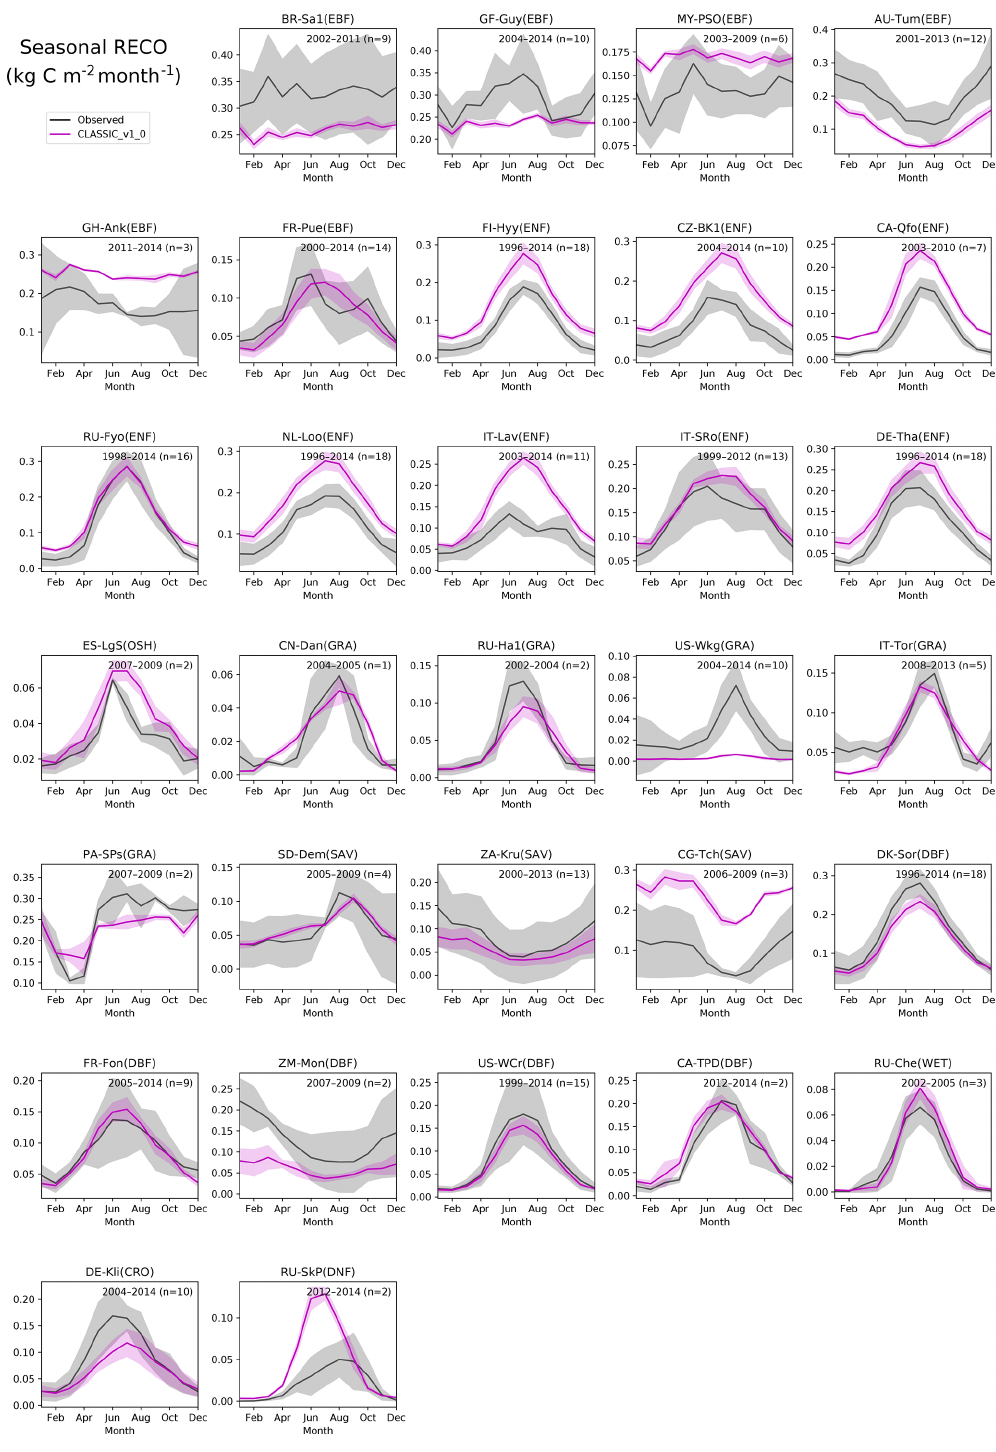
Figure 9. The mean seasonal cycle of RECO for 31 FLUXNET sites as simulated by CLASSIC. The IGBP biome of each site is listed alongside its FLUXNET name (see Table 1). Shaded regions indicate the standard deviation across the sample years. See caption of Fig. 5 for biome